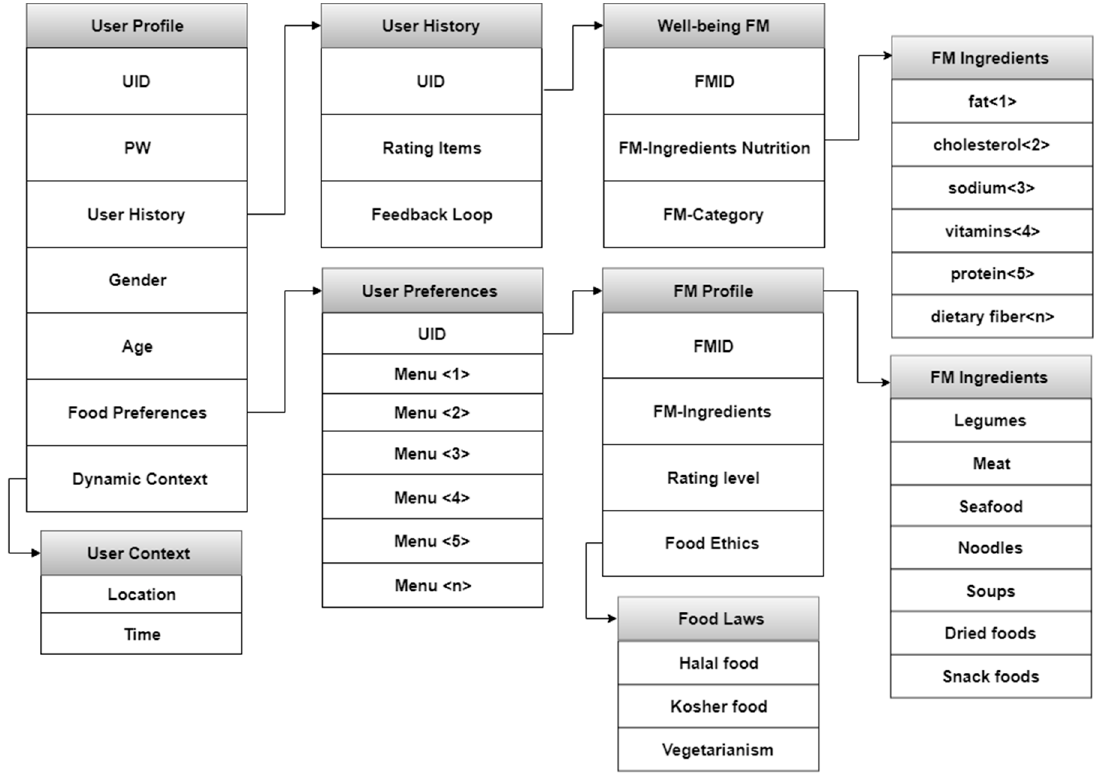
Figure 5. Profile structure.